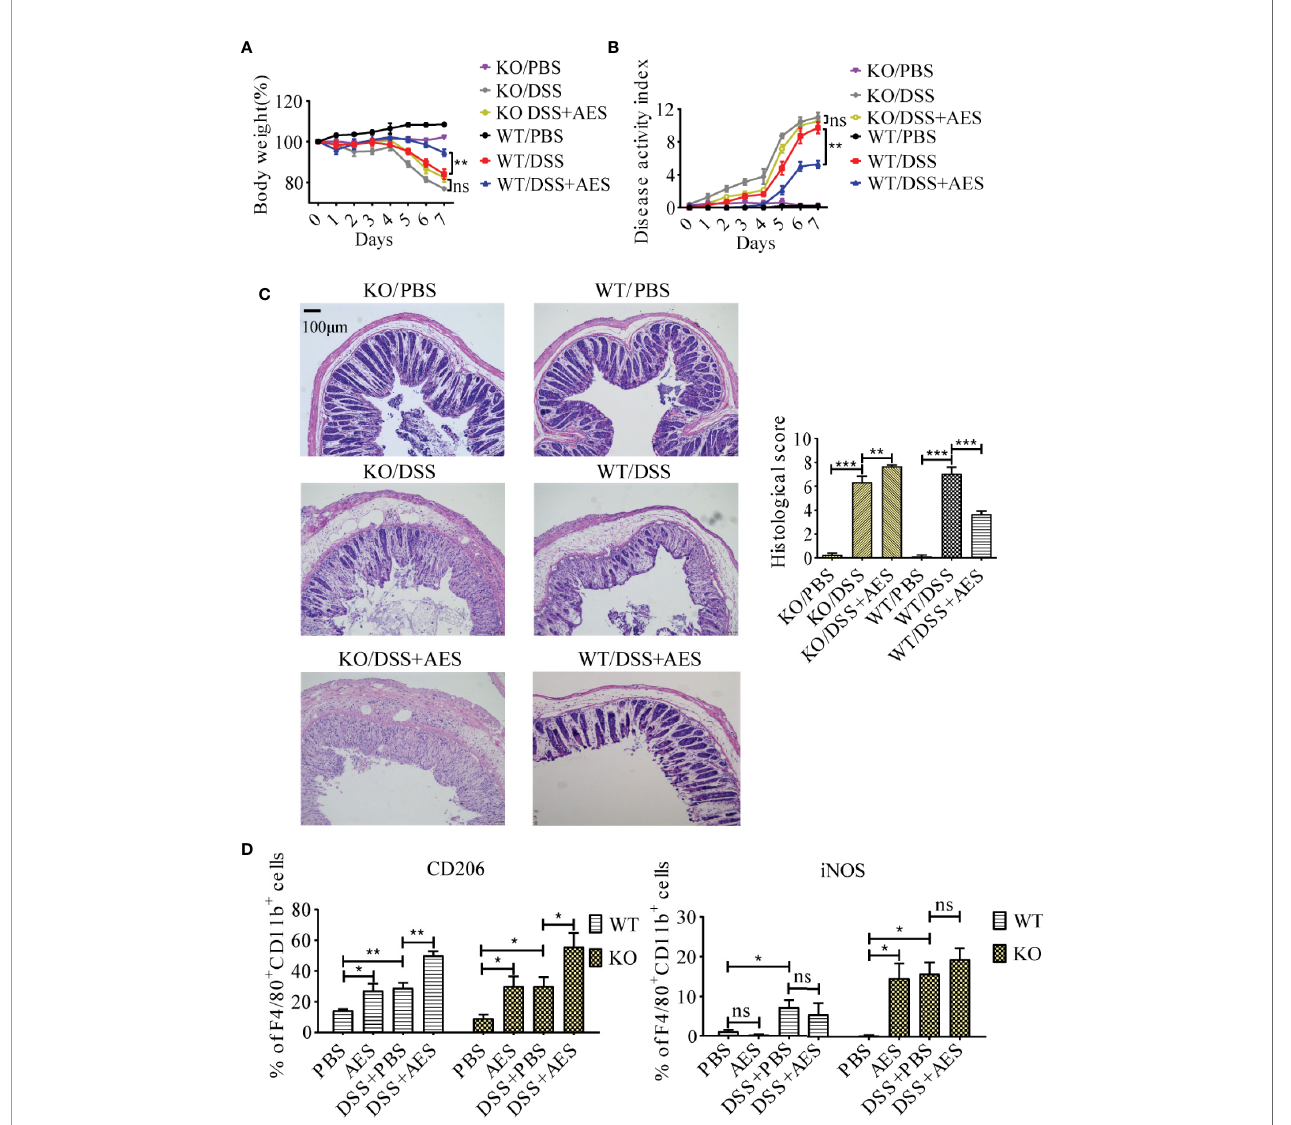
FIGURE 6 | PD-1 de fi ciency offset the protective effects of AES on DSS-induced colitis. The WT C57BL/6 mice (WT) and PD-1 knockout mice (KO) were divided into 3 groups with 6 mice each, treated with DSS, DSS+AES, and PBS, respectively. (A) Quanti fi cation of weight loss in different groups (n=6). (B) Clinical disease activity index (DAI) was evaluated throughout the experimental period (n=6). (C) Microscopic histological damage (left) and score (right) in different treatment groups (n=5). (D) PD-1 de fi ciency enhanced both M1 (iNOS) and M2 (CD206) expression in PD-1 knockout mice with DSS-induced colitis treated with AES as compared to untreated mice (n = 6). Experiments were repeated in triplicate. All data are expressed as means ± SEM. * P < 0.05, ** P < 0.01, *** P <